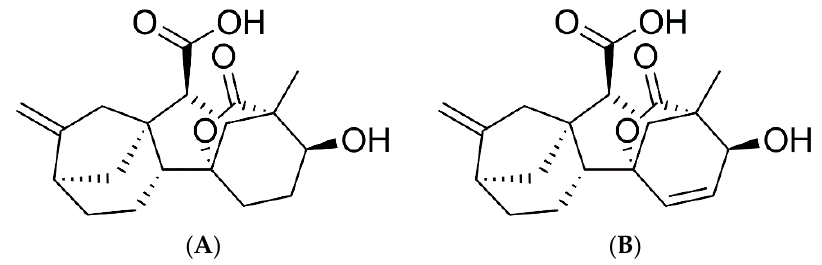
Figure 1. Chemical structures of gibberellin A4 ( A ) and gibberellin A7 ( B